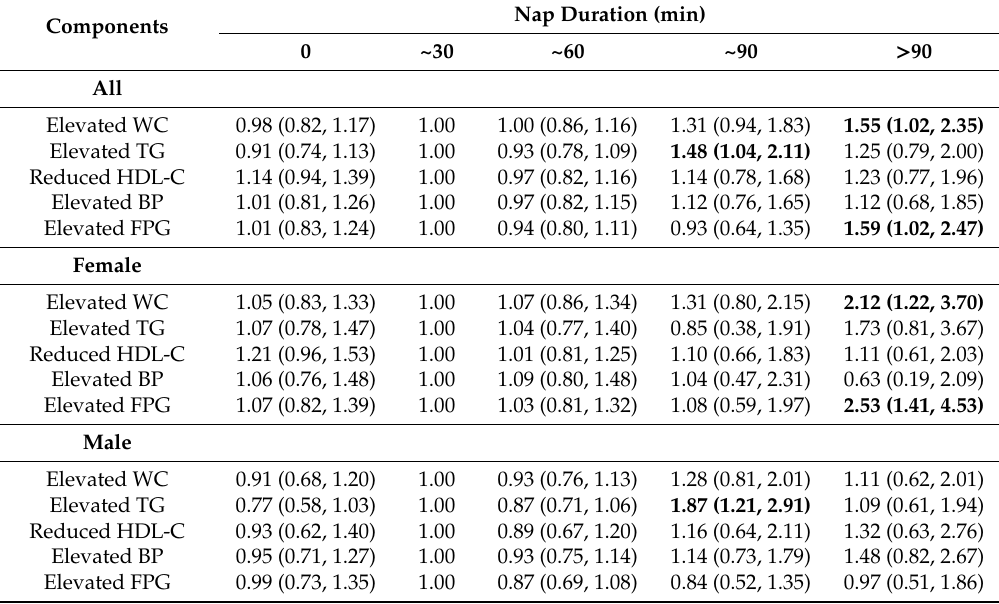
Table 2. Adjusted odds ratios (ORs) of components of metabolic syndrome for nap duration